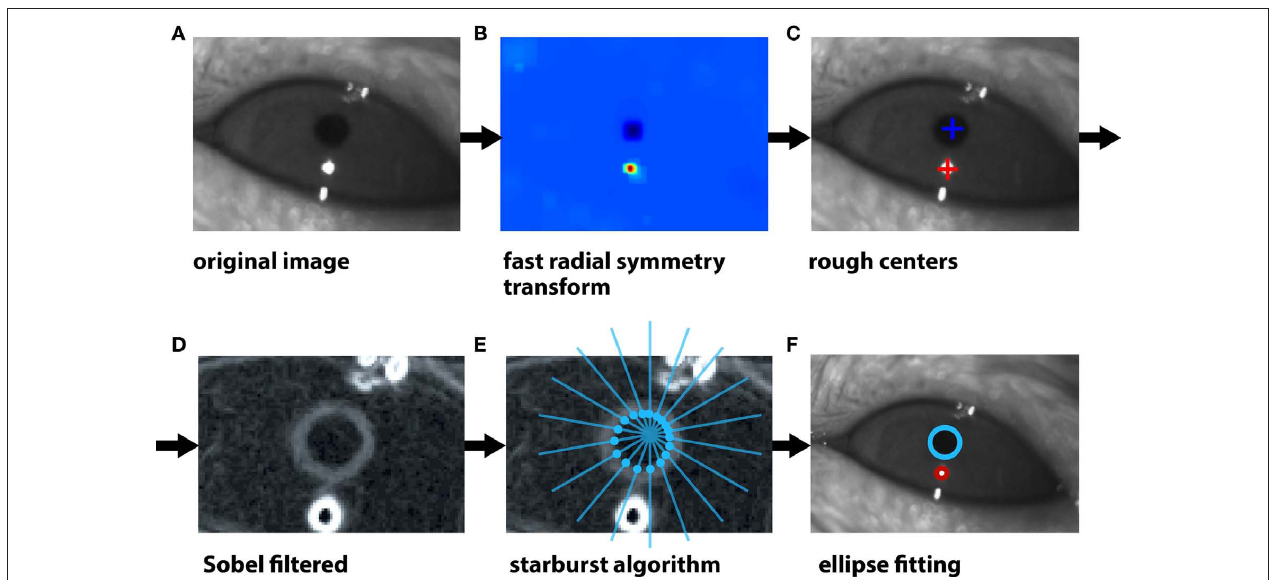
image of the eye to find the boundaries of the pupil (gray ring) and CR (white ring). Note that the eye is shown at higher magnification in this panel (as compared to A–C ). (e) The previously found rough center of the pupil (see C ) is used as a seed point to project a set of “rays” (blue lines) toward the boundary of the pupil itself. The Sobel-filtered image is sampled along each ray and when it crosses a given threshold (proportional to its standard deviation along the ray), an intersection between the ray and the pupil boundary is found (intersections are shown as blue, filled circles). The same procedure is used to find a set of edge points along the CR boundary. (F) An ellipse is fitted to the boundary points of the pupil (blue circle) and CR (red circle) to obtain a precise estimate of their